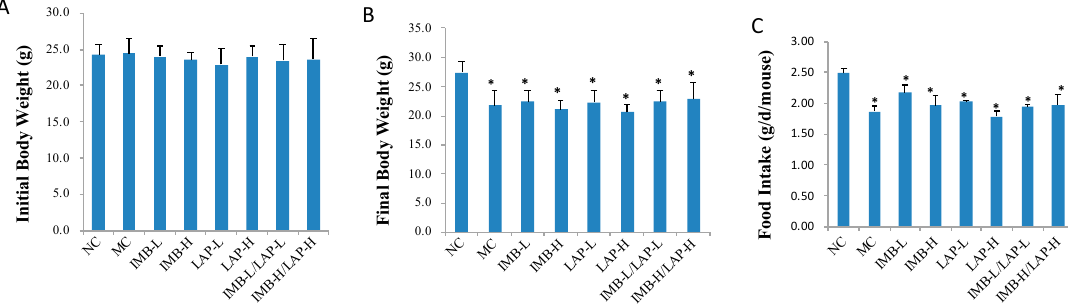
Figure 1. Effects of IMB and LAP treatments on body weight of CKD mice. A, initial body weight; Figure 1. E ff ects of IMB and LAP treatments on body weight of CKD mice. ( A ), initial body weight; ( B ), final body weight; ( C ), food intake. Data was presented as Mean ± SD, and analyzed by